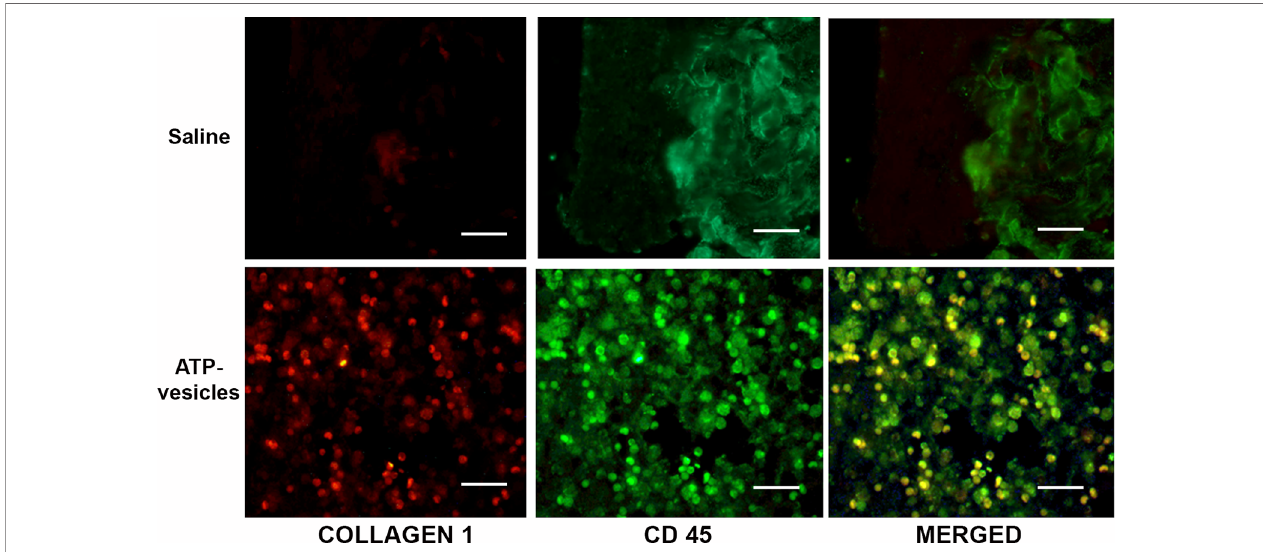
FIGURE 5 | Co-localization study with CD45 and collagen type I antibodies at day 3. Positive collagen I (red) and CD45 (green) stainings were observed in the ATP- vesicle – treated wounds, demonstrating neovascularization and matrix formation in these wounds as early as day 3 after surgery (scale bar = 50 m m). Saline-treated wounds didn ’ t show any